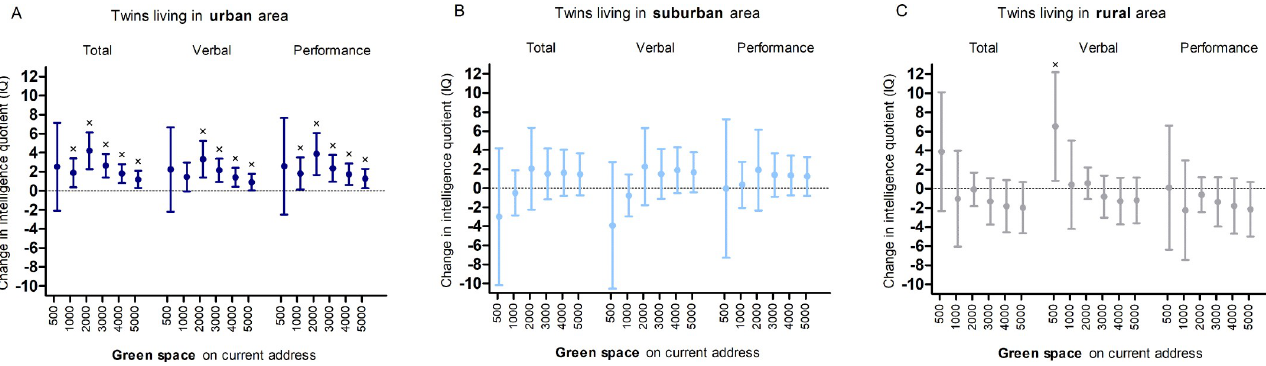
Fig 2. Estimated change in IQ for an IQR increase in green space in a 500–5,000-m radius around the residence in twins living in (A) an urban ( n = 234), (B) a suburban ( n = 128), and (C) a rural area ( n = 252) adjusted for sex, age, parental education, neighborhood household income, year of IQ test, and zygosity and chorionicity. We expressed the estimates for an IQR change in percentage green space for buffers from 1,000 to 5,000 m. Because of the skewedness of the data for the 500-m radius (and 1,000 m in rural), we expressed the effect size for a dichotomized variable representing the presence or absence of green space within this buffer. IQ, intelligence quotient; IQR, interquartile